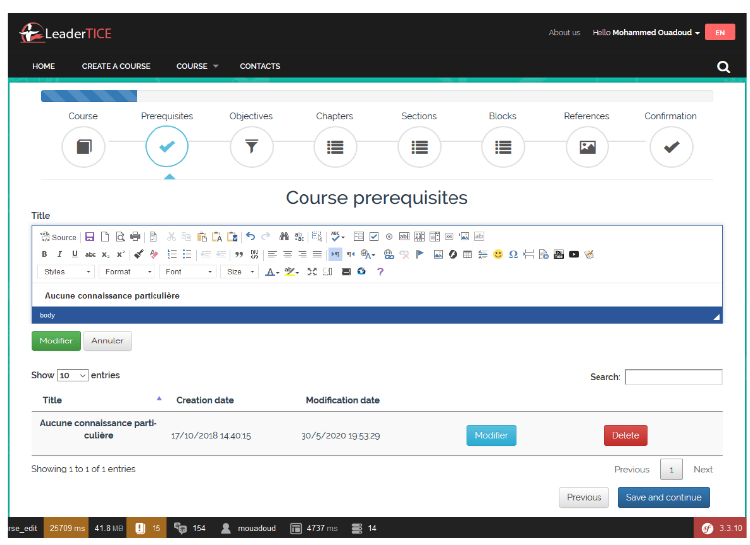
Fig. 4. Course prerequisite interface developed by the NoSQL MongoDB